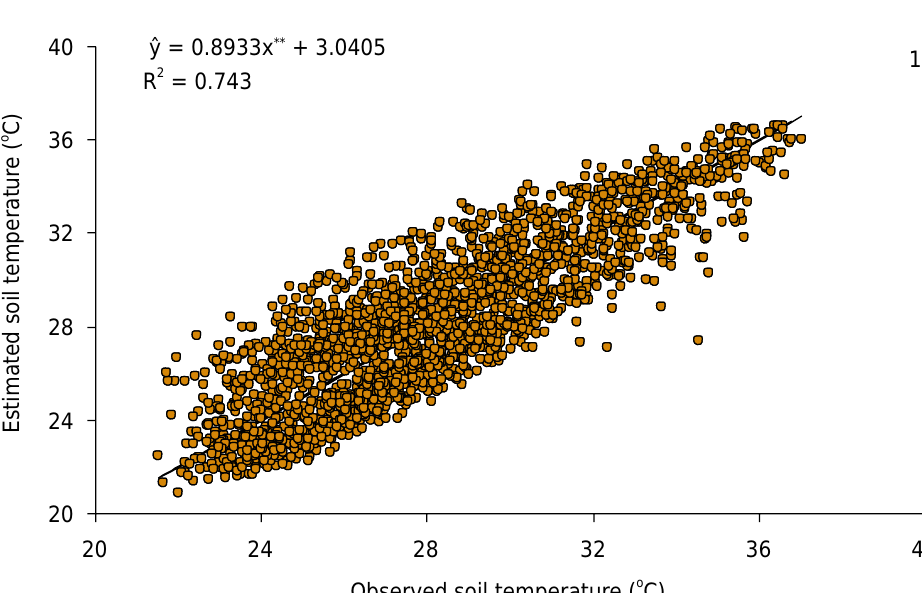
Figure 3. Evaluation of the predictive capacity of the linear regression equations developed between air temperature and soil temperatures to the depth of 0.05 m of a Cambissolo Háplico Ta Eutrófico (Cambisol; Inceptisol) for July, September, and December 2016, in São Gabriel, Irecê Identity Territory, Bahia, Brazil.